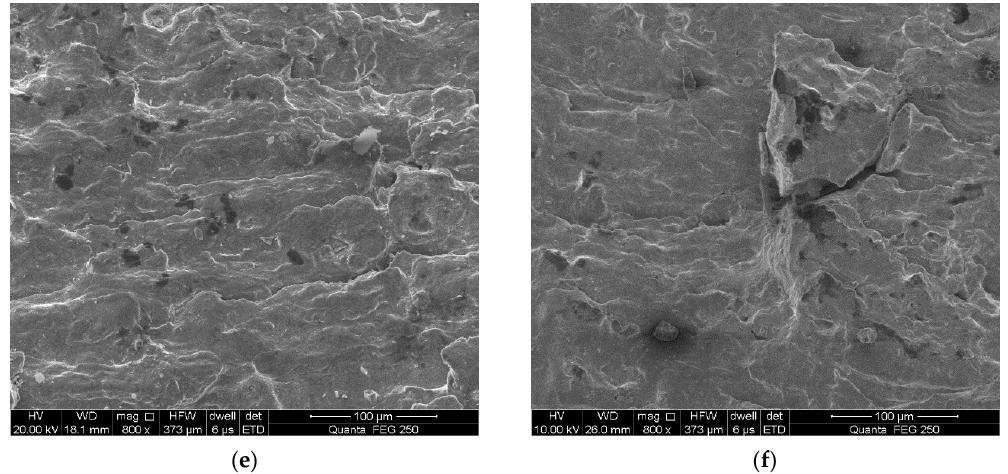
Figure 7. The fatigue crack propagation region ( a ) ±0.5% (air), ( b ) ±0.2% (air), ( c ) ±0.5% (mixed chloride salt), ( d ) ±0.2% (mixed chloride salt), ( e ) ±0.5% (mixed sulfate salt), and ( f ) ±0.2% (mixed sulfate salt).